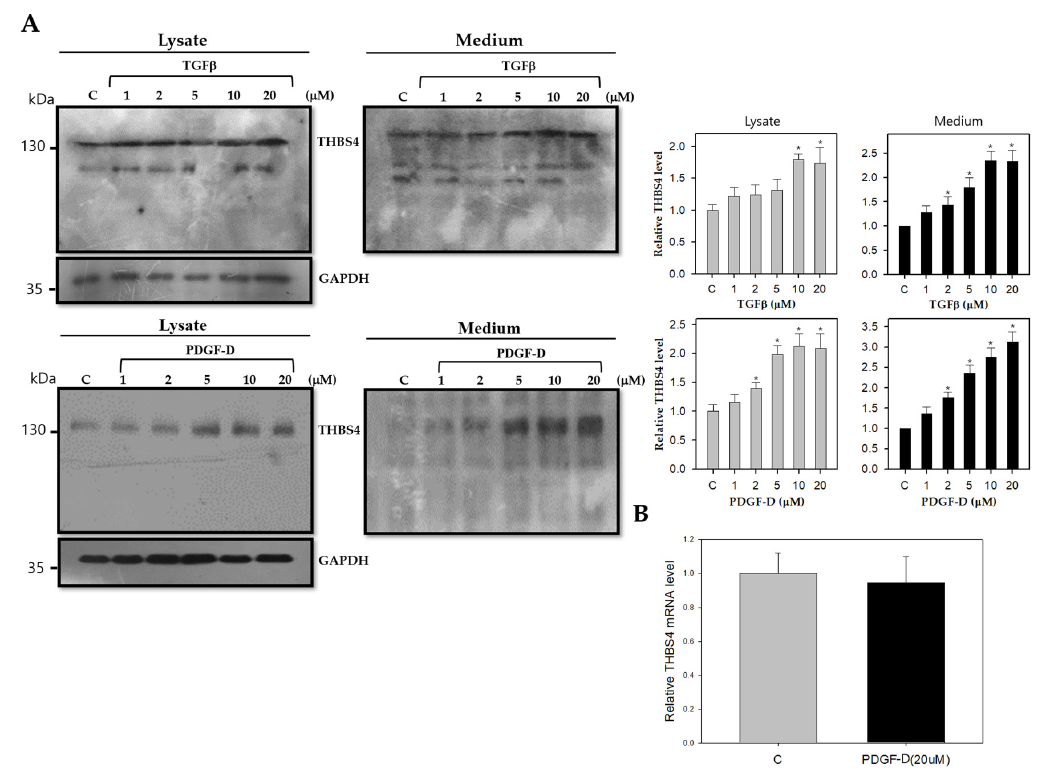
Figure 3. Effect of TGF β or PDGF-D on THBS4 of lysate and cultured medium of DLD-1 cells. ( A ) Western blot with anti-THBS4 antibody in whole cell lysate (left panel) or cultured medium (right panel) of DLD-1 cells cultured in the presence of TGF β (1, 2, 5, 10 and 20 µM) for 20 h or PDGF-D (1, 2, 5, 10, and 20 µM) for 8 h. ( B ) Relative mRNA expression levels as determined with real-time polymerase chain reaction (PCR) for THBS4 of DLD-1 cells cultured in the presence (black) or absence (gray) of PDGF-D (20 µM) for 8 h. Three independent experiments were performed in duplicate. * p < 0.05 when compared with the control t- test .